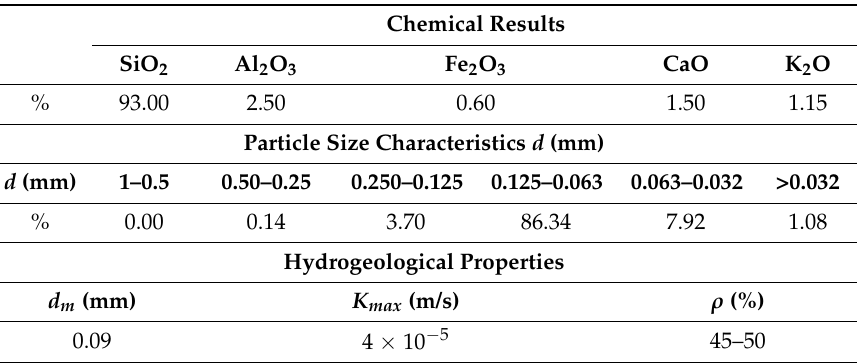
Table 1. Chemical and hydrogeological parameters of the sand used for the experiment. d m , K max , and ρ represent average diameter of the sand, hydraulic conductivity and porosity, respectively.